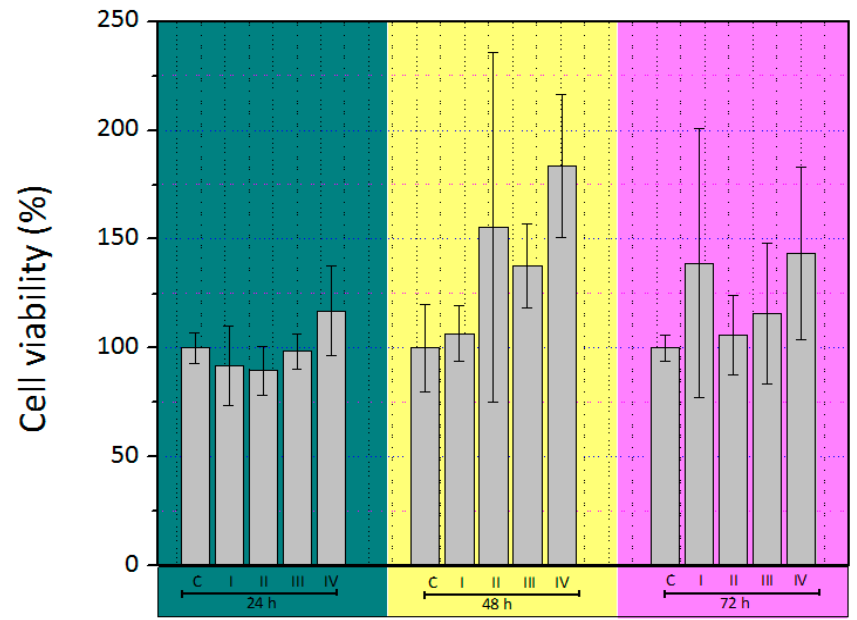
Figure 3. 3-(4,5-dimethylthiazol-2-yl)-2,5-diphenyltetrazoliumbromide (MTT) assay of skin cells growing on different DM for 24, 48, and 72 h. * p < 0.05.